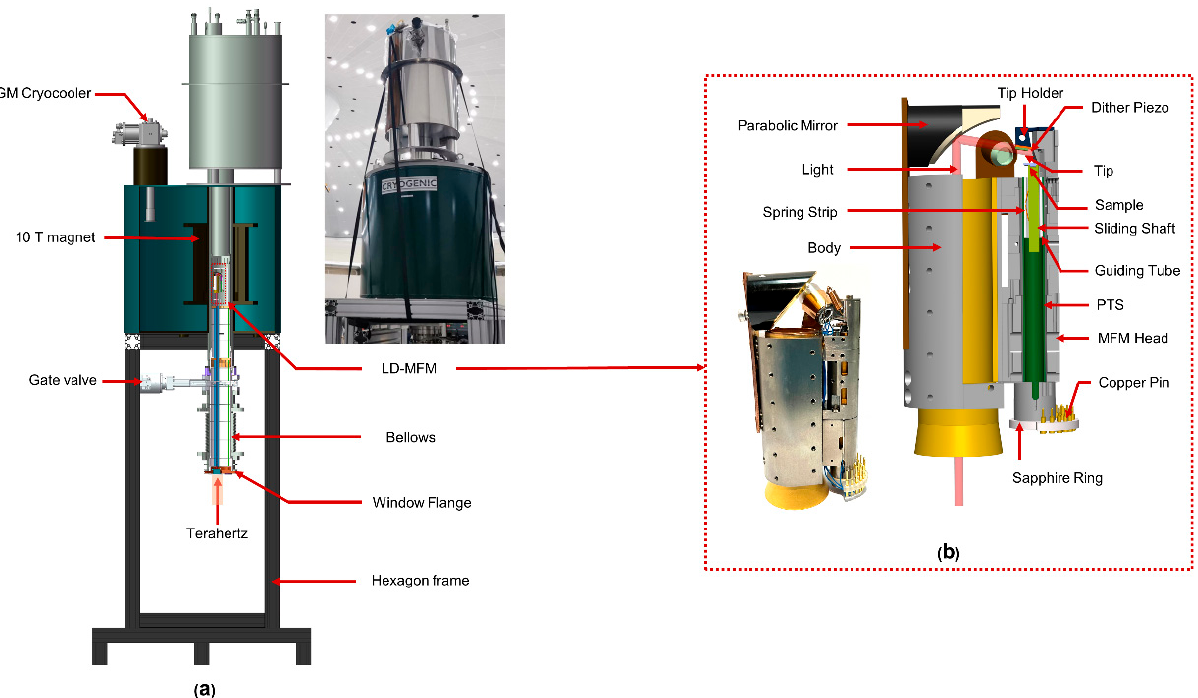
Figure 5. ( a ) Photo (upper right) and three-dimensional cross-sectional view (left) of the LD-SPM system in a 10 T cryogen-free superconducting magnet. ( b ) Photo (lower left) and three-dimensional model (right) of the LD-MFM.